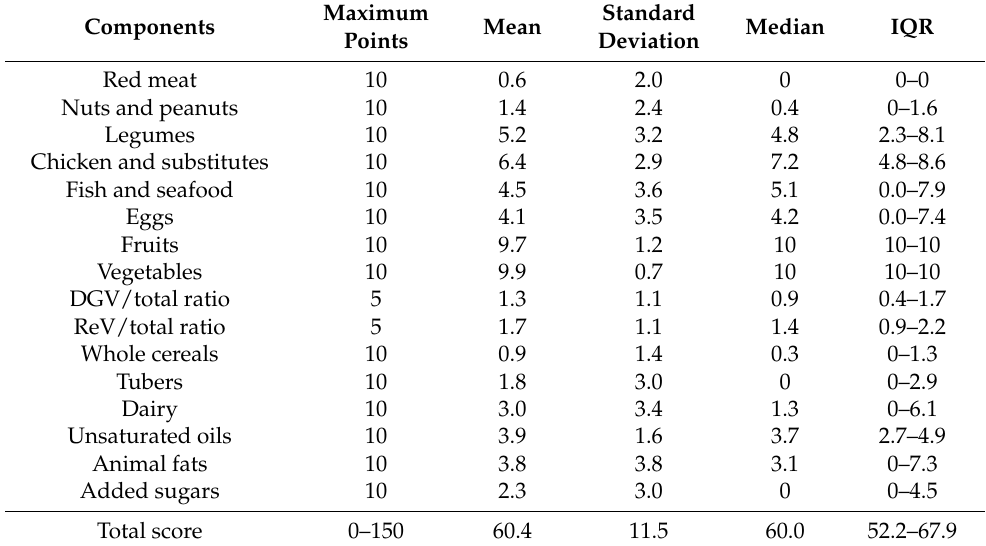
Table 2. Descriptive analysis of Planetary Health Diet Index components (values expressed as mean and standard deviation, and median and interquartile range). ELSA-Brasil, 2008–2009.